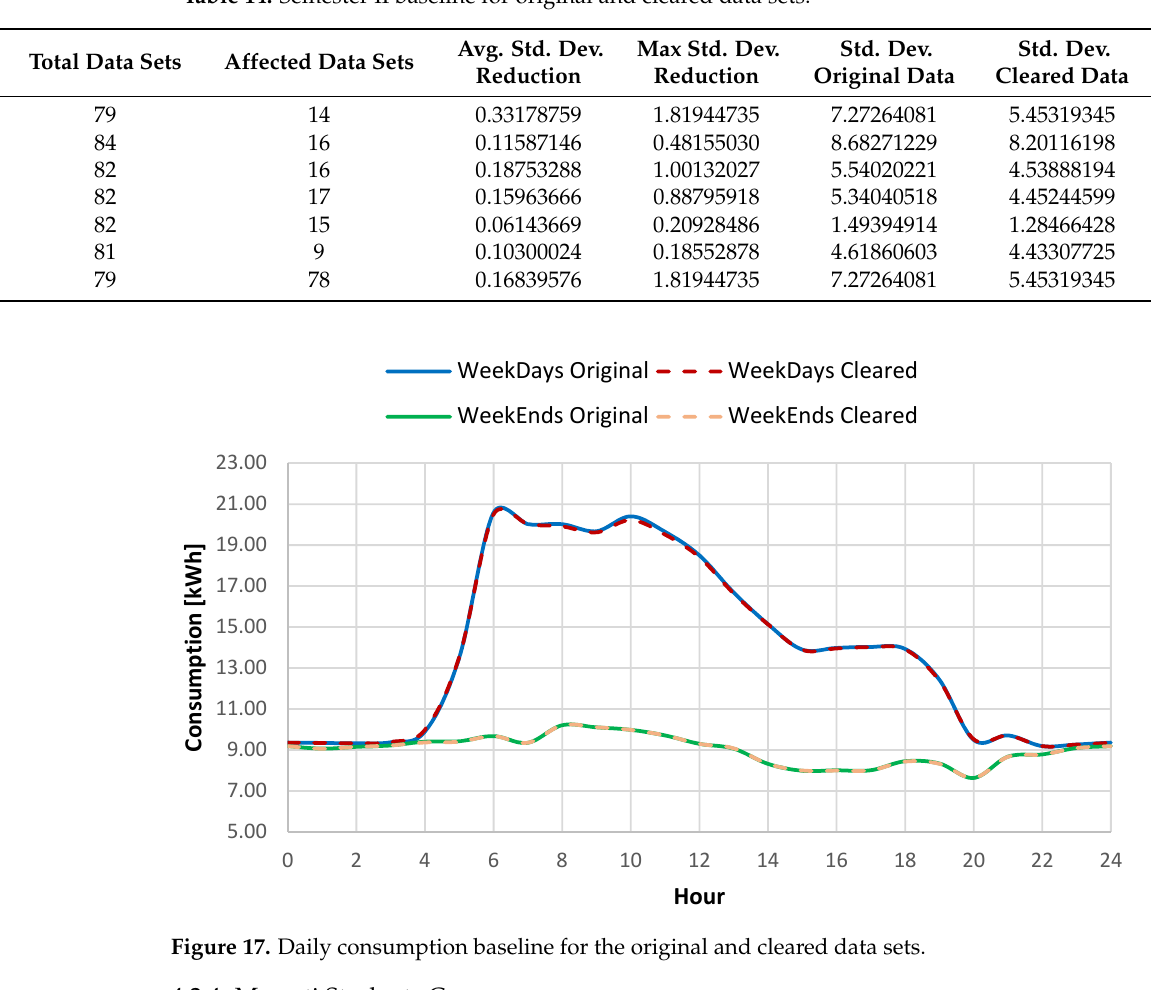
Table 15. Full year baseline for original and cleared data sets.